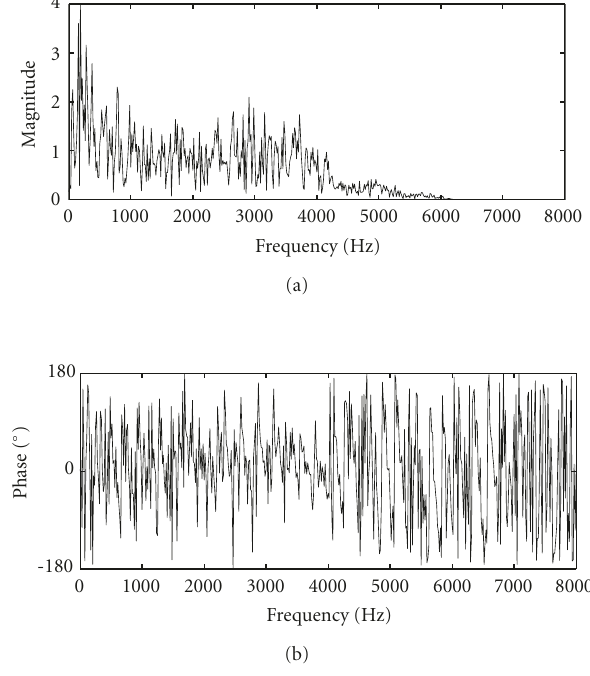
Figure 5: Typical (a) magnitude and (b) phase of measured room transfer function in the corridor hall.